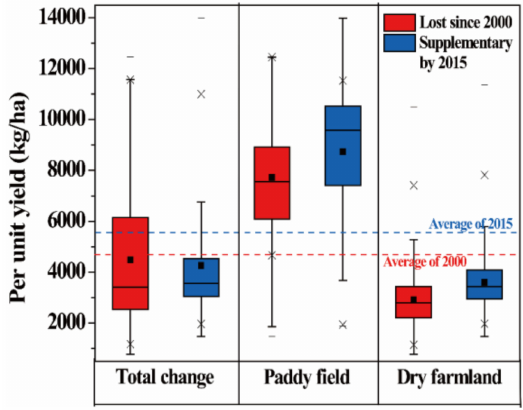
Figure 11. The statistical characteristics of cultivated land change from 2000 to